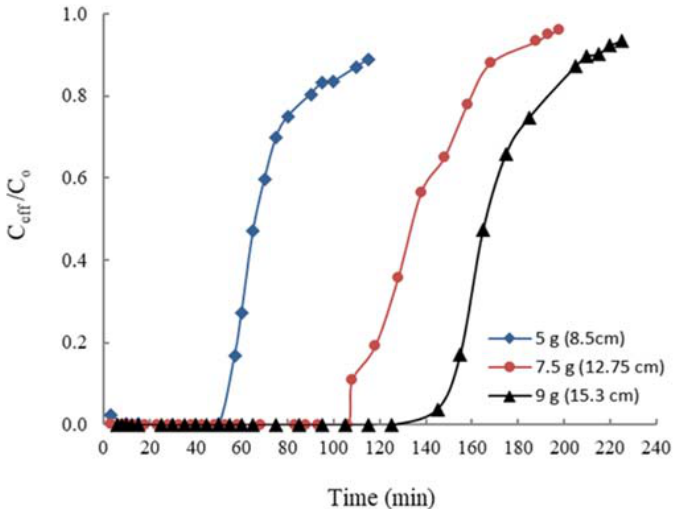
Figure 6. Different bed depths effect on the adsorption’s curves of breakthrough onto RHAC (rate of flow of 10 mL/min; inlet phenol concentration of 1000 mg/L).